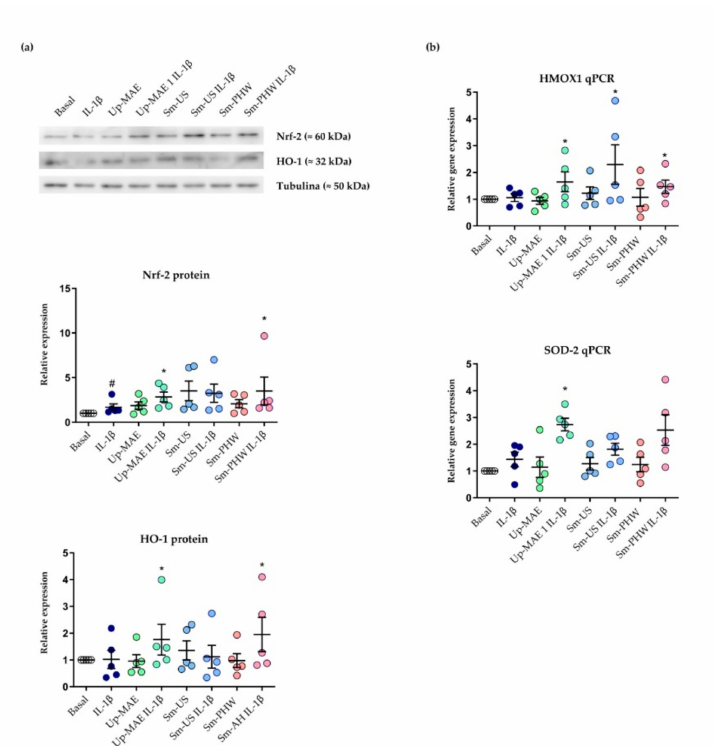
Figure 8. Effect of crude fucoidans on antioxidant response of 260TT cell line. ( a ) Nrf-2 and HO-1 protein levels were measured by Western blot ( n = 4) in cells treated with crude fucoidans at 5 µ g/mL with and without IL-1 β for 24 h. Protein band intensities were quantified by densitometry with ImageQ image-processing software and relative expression of targeted protein was calculated and normalized by values of its related tubulin band intensity. ( b ) gene levels of HMOX-1 and SOD-2 were assessed by qPCR ( n = 4) in cells treated with crude fucoidans at 5 µ g/mL with and without IL-1 β for 6 h. IL-1 β condition is statistically different from basal condition (#: p -value < 0.05). Conditions marked with * are statistically different from IL-1 β condition (*: p -value <